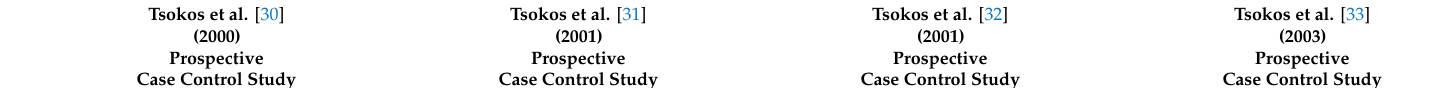
Table 3. Molecules assessed as potential post-mortem immunohistochemical markers of